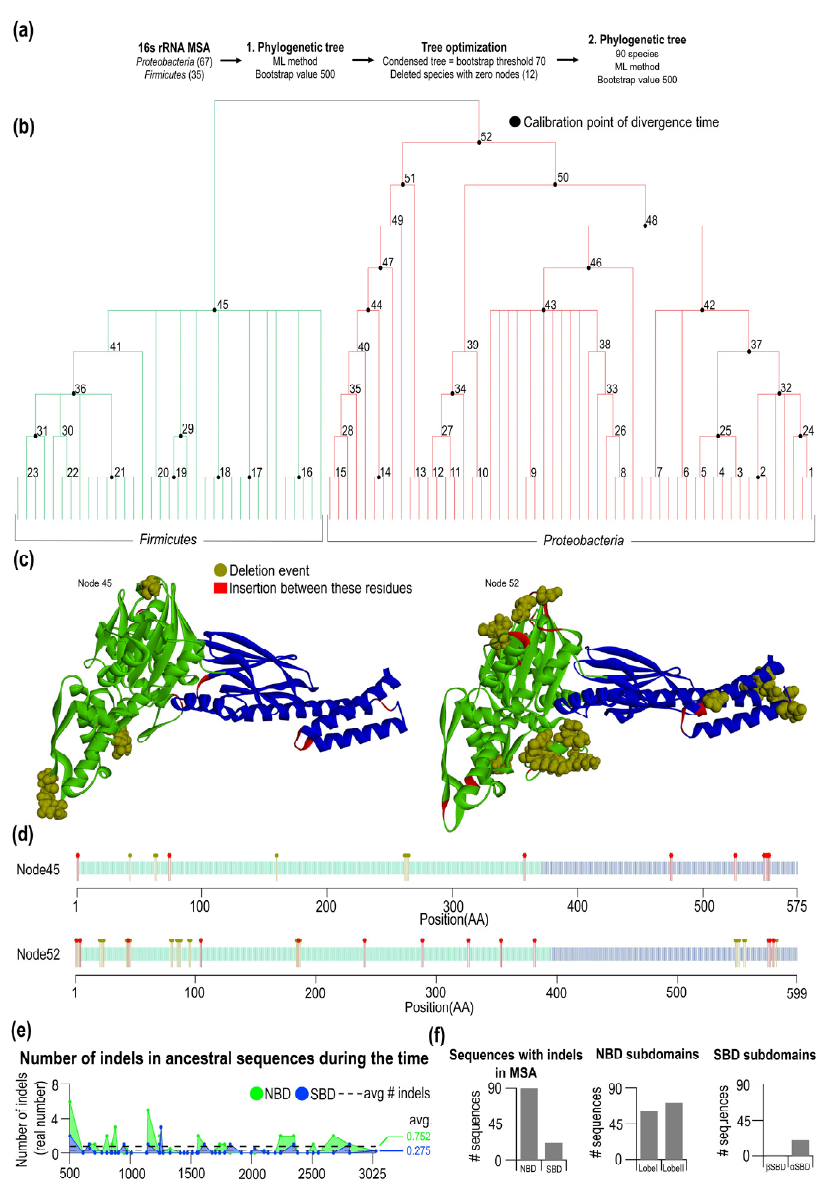
Figure 3. Condensed 16S rRNA phylogenetic tree of Proteobacteria and Firmicutes and indels evolution in ancestral sequences. ( a ) Workflow of the 16S rRNA phylogenetic tree construction steps. ( b ) The condensed form of the 16S rRNA phylogenetic tree of Proteobacteria and Firmicutes was constructed by the maximum likelihood method with 52 nodes. Black circles represent calibration points, from which the divergence time was calculated. ( c ) DnaK predicted structures of the oldest ancestral sequences for both Proteobacteria (node 52) and Firmicutes (node 45). Positions where the indels occur during analyzed evolution are colored red (insertions) and brown (deletions). ( d ) Schematic sequences of the oldest ancestral sequences of Proteobacteria and Firmicutes with colored indels positions. ( e ) Number of indels in Proteobacteria and Firmicutes ancestral DnaK domains (NBD avg. = 0.752, SBD avg. = 0.275) during the evolution. The indels ratio for every node is divided by the number of sequences in node-1. ( f ) The number of identified indels in the present domains and subdomains of Proteobacteria and Firmicutes DnaK